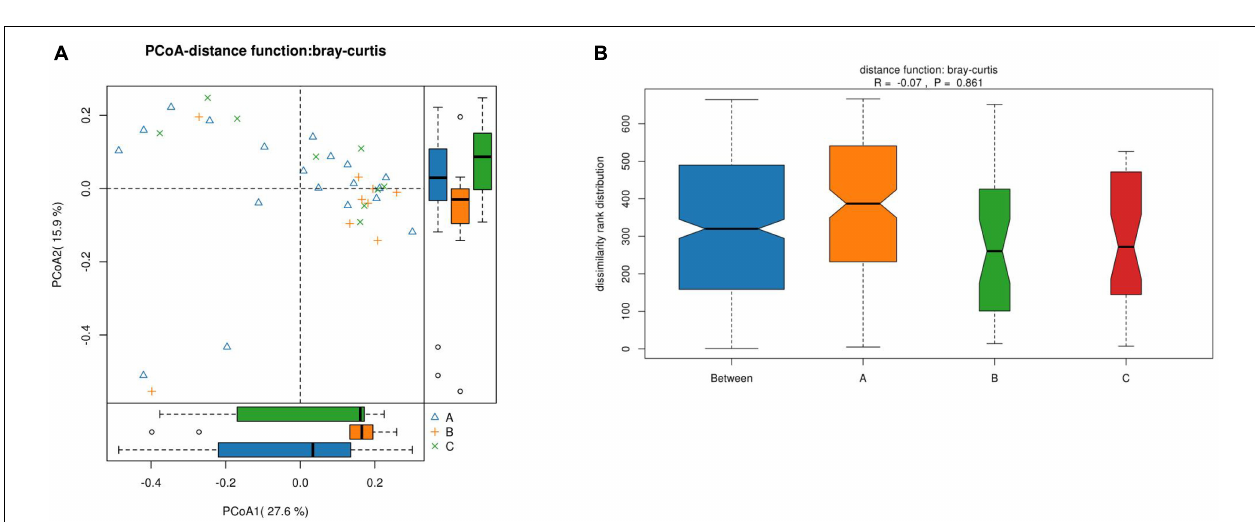
FIGURE 5 | Observed species of the three groups of samples. (A: acute stage of IgAV-GI, B: recovery stage of IgAV-GI, C: IgAV-non-GI).